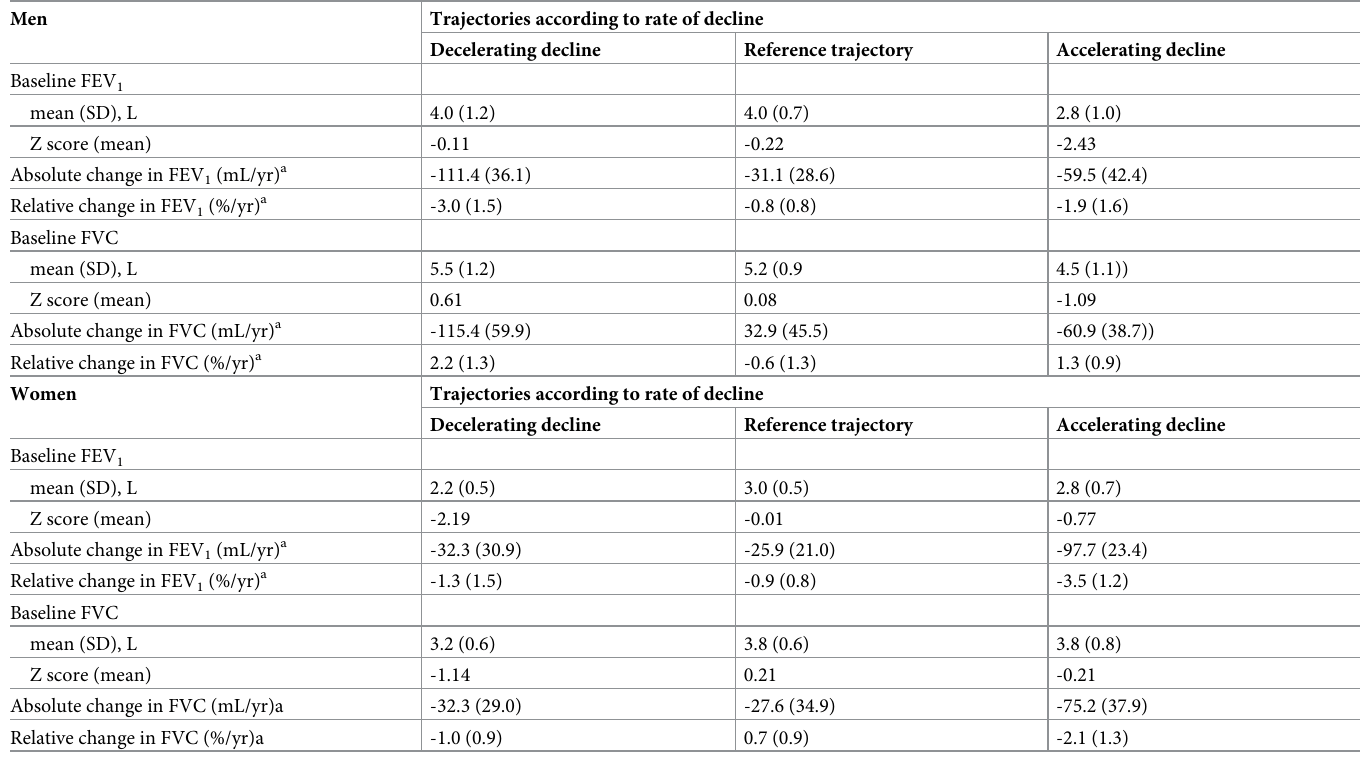
Table 2. Baseline FEV 1 , absolute and relative change in FEV 1 for men and women in each of the FEV 1